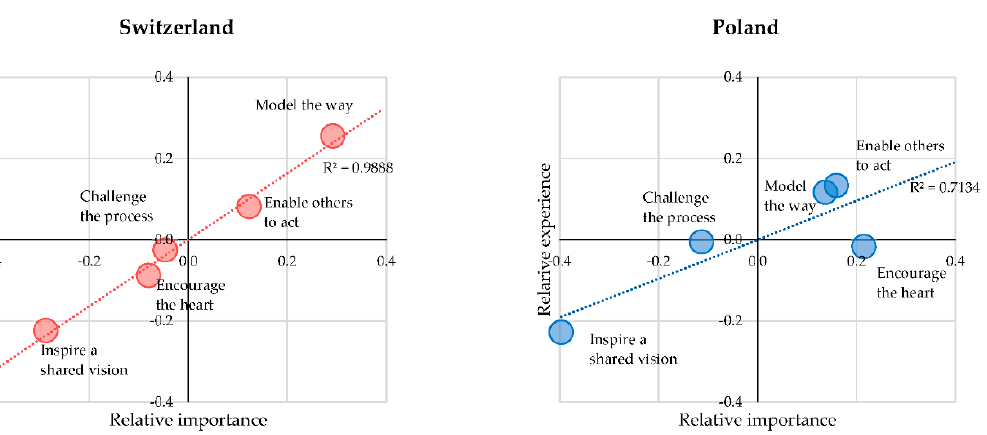
Figure 2. Relative importance vs. experience by employee country.